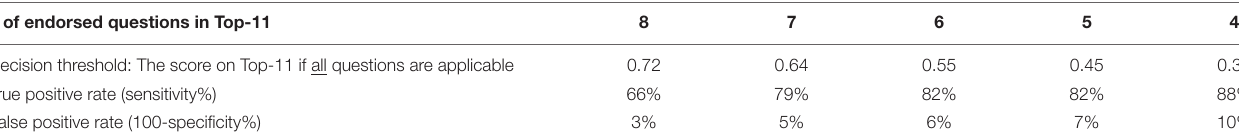
FIGURE 2 | The distribution of scores for each question for children with CVI (red) and typical children (blue). For children with CVI, the median is shown in red right-pointing triangles; the mean is shown in red stars. For typical children, the median is show in blue left-pointing triangles; the mean is shown in blue dots. Error bars represent the 25th and 75th percentiles. To avoid overlapping of the plots, data for typical children is moved rightward by 10% of the unit. C1–C7 mark the 7 categories in Dutton et al. (2010). Questions in the Top-11 (vertical lines) and Dutton’s Five (half circles) are marked on the horizontal axis (see Table 4 ). TABLE 5 | True and false positive rates for the Top-11 in our group of children with CVI and typical children, based on decision